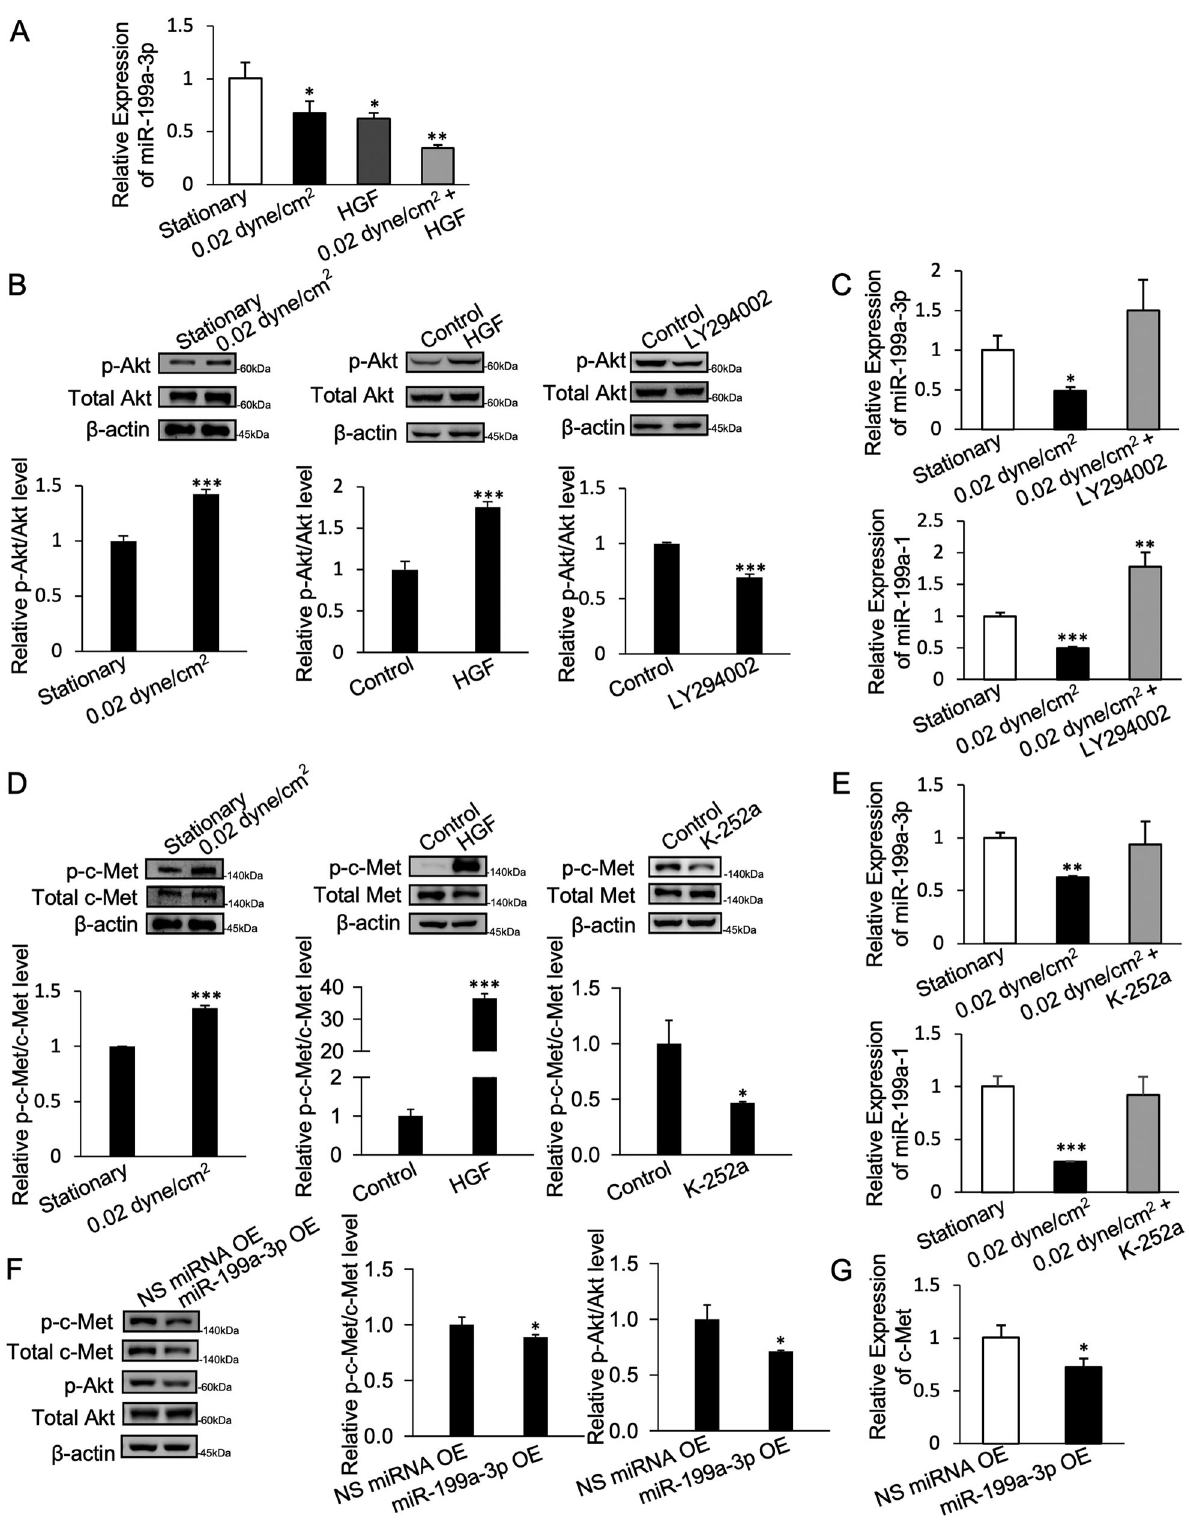
Fig. 3 c-Met/PI3K/Akt pathway regulates miR-199a-3p through a positive feedback loop. A Expression of miR-199a-3p under shear stress, HGF treatment, and combination of shear stress and HGF. B Expression of p-Akt and total Akt under shear stress, HGF, and LY 294002 treatment. C Expression of miR-199a-3p and miR-199a-1 when treated with LY 294002 under shear stress. D Expression of p-c-Met and total c-Met under shear stress, HGF, and c-Met inhibitor K-252a. E Expression of miR-199a-3p and miR-199a-1 when treated with K-252a under shear stress. F Expression of p-c-Met, total c-Met, p-Akt, total-Akt, and G . c-Met mRNA in miR-199a-3p overexpressing cells. Bar graph values are mean ± SD, n = 3 for q-PCR and mean ± SD of three replicate measures of respective bands for Western Blot quanti fi cation. T -test. * P < 0.05, ** P < 0.005, *** P < 0.0005.